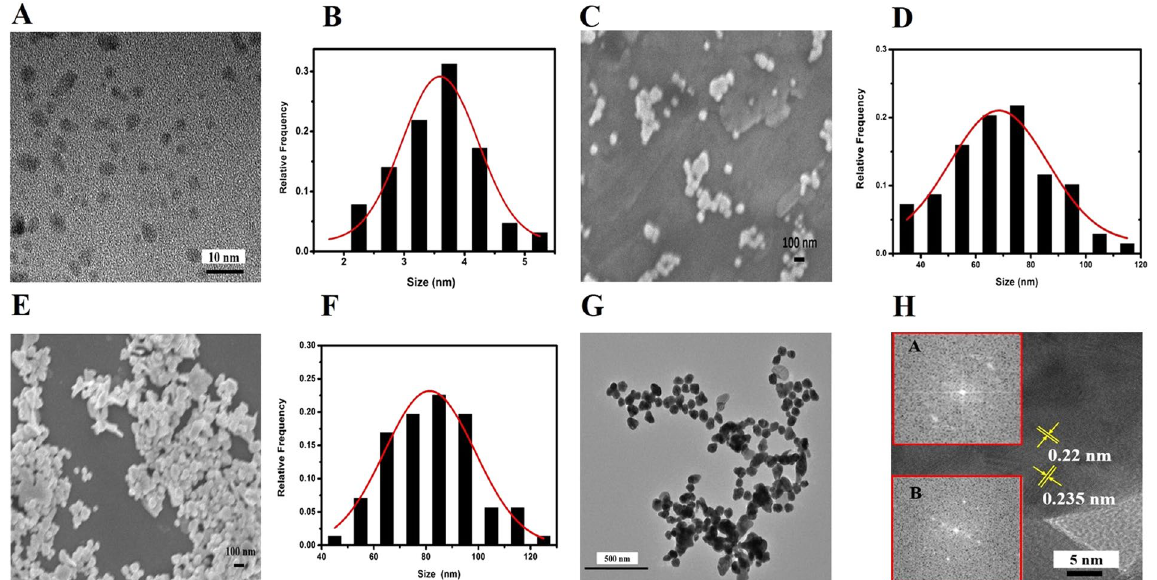
Figure 1. ( A ) TEM images of N-GQD, and the SEM images of the synthesized ( C ) Ag NPs and ( E ) Ag NP@N- GQD. The images ( B , D and F ) show the size histograms of N-GQDs, Ag NPs and Ag NP@N-GQD derived from SEM images, respectively. ( G ) TEM images of the as-synthesized Ag NP@N-GQD. ( H ) HRTEM images of Ag NP@N-GQD and FFT patterns of N-GQDs and N-GQDs Ag NP shown in inset a and b,